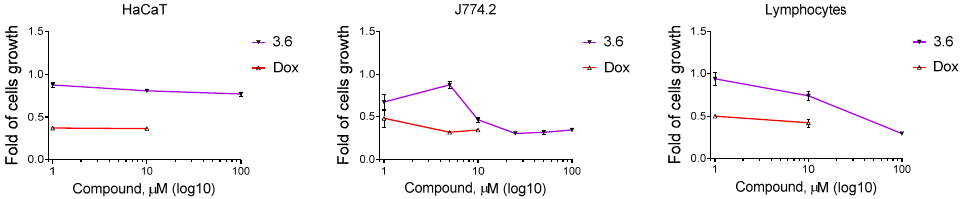
Figure 5. The viability of human keratinocytes of HaCaT line, murine macrophages of J774.2 line, and isolated normal human peripheral blood lymphocytes upon exposure to different concentra- tions of compound 3.6 and doxorubicin (Dox) for 72 h. The anti-proliferative activity of studied compounds was analyzed by MTT assay after 72 h of cells exposure. Data presented as M ± SD, n = 3.